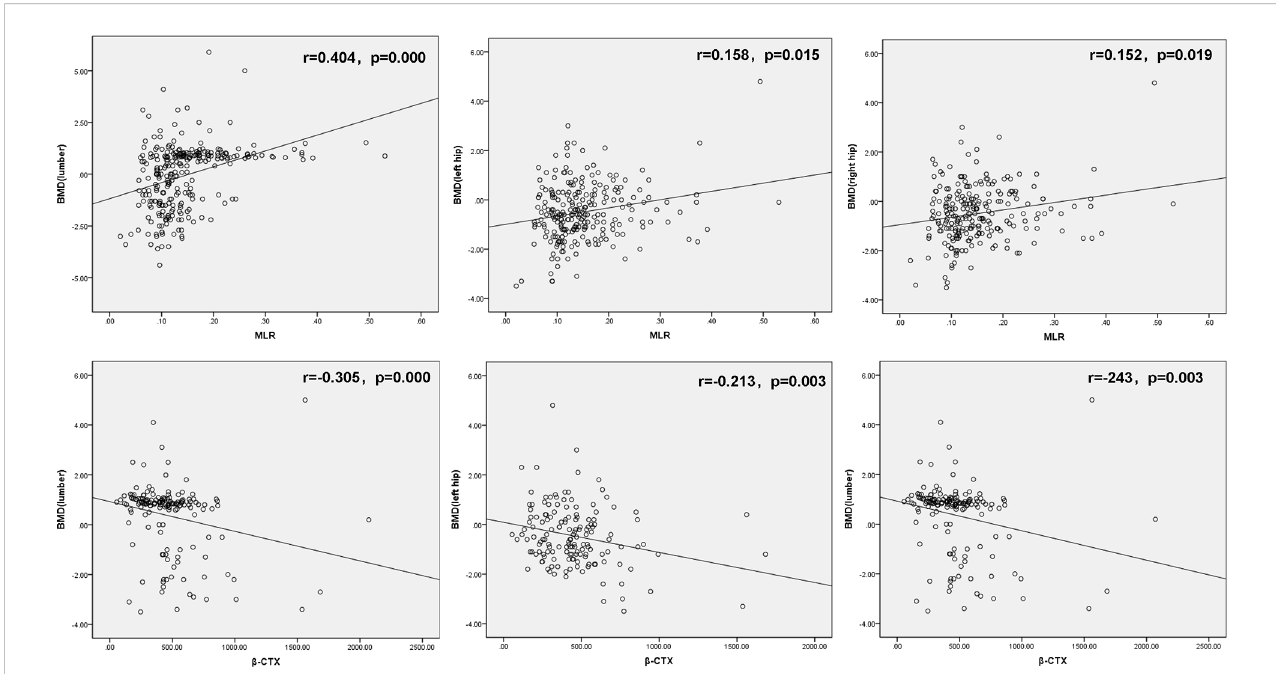
FIGURE 1 Correlation analysis of MLR with hip and lumbar BMD (up); Correlation analysis of MLR with hip and lumbar BMD (down). MLR, monocyte-to-lymphocyte ratio, b -CTX, C-terminal telopeptide of type I collagen and BMD, bone mineral density.